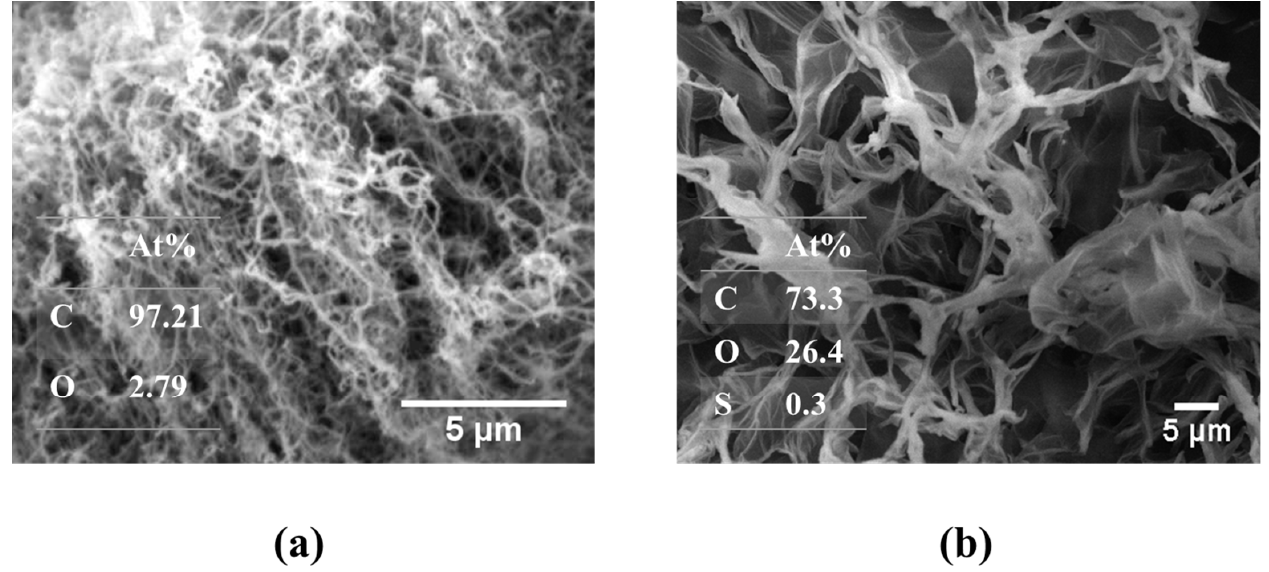
Figure 1. FESEM micrographs of ( a ) MWCNTs and ( b ) GO nanosheets, including their corresponding EDS spectra as insets.